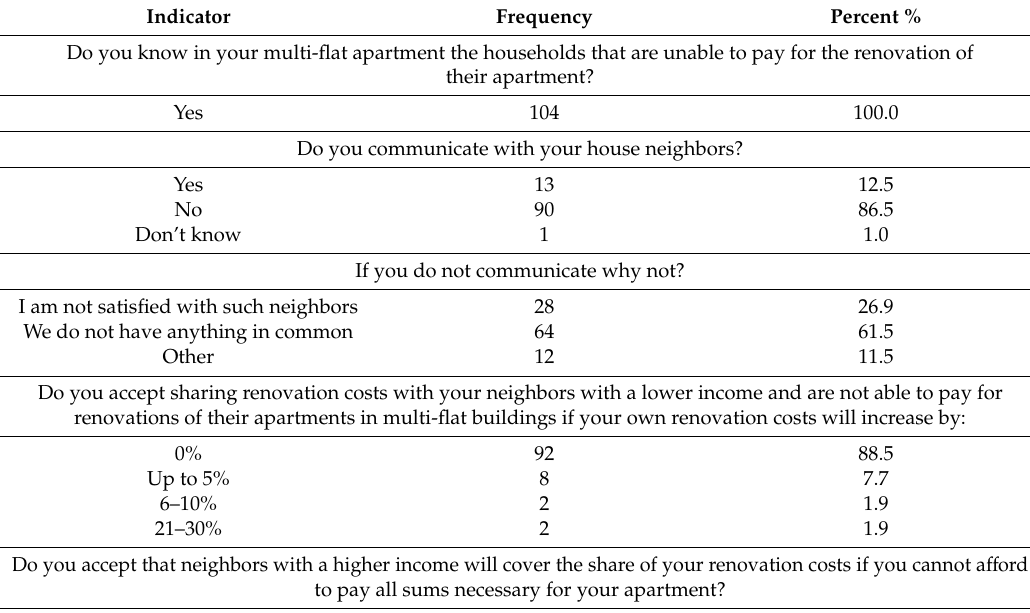
Table 7. Willingness to share renovation costs with lower income